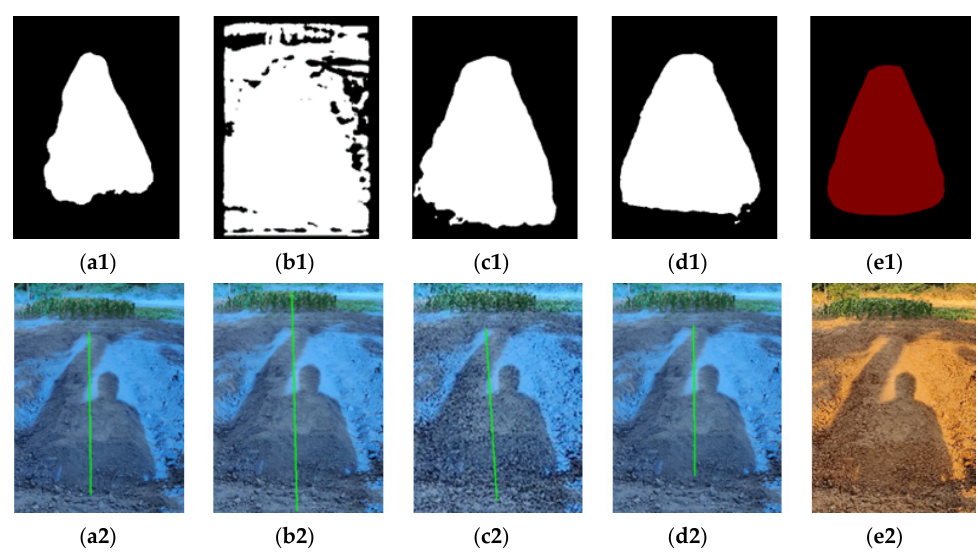
Figure 7. Outcome Prediction. ( a1 ) Unet prediction mask. ( b1 ) VGG prediction mask. ( c1 ) Res2net50 pre-diction mask. ( d1 ) Our model prediction mask. ( e1 ) Label. ( a2 ) Unet model navigation line fitting. ( b2 ) VGG model navigation line fitting. ( c2 ) Res2net50 model navigation line fitting. ( d2 ) Our model model navigation line fitting. ( e2 ) Original.